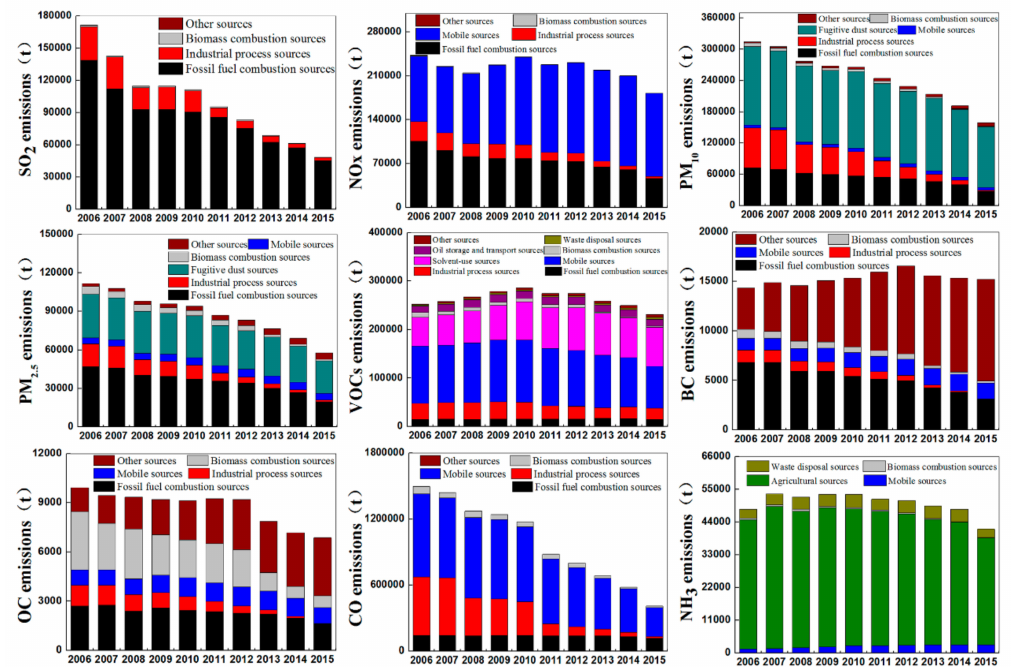
Figure 2. Historical trends of primary air pollutant emissions in Beijing,